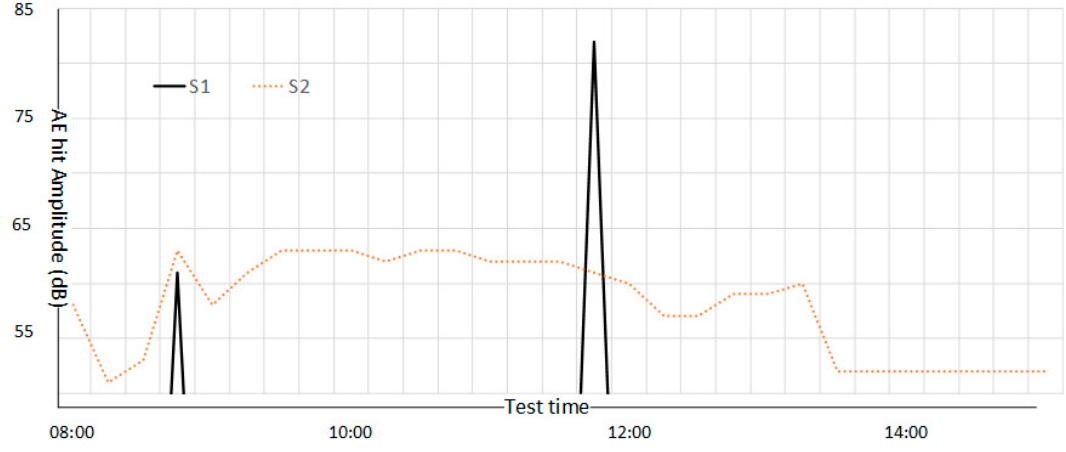
Figure 10. Maximum amplitude AE detected (15 min block period) during blade test bolt